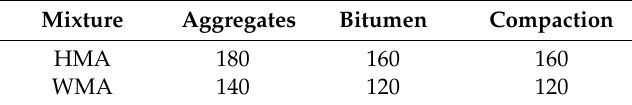
Table 4. Temperatures for hot mix asphalt (HMA) and warm mix asphalt (WMA) specimens’ preparation (in °C).